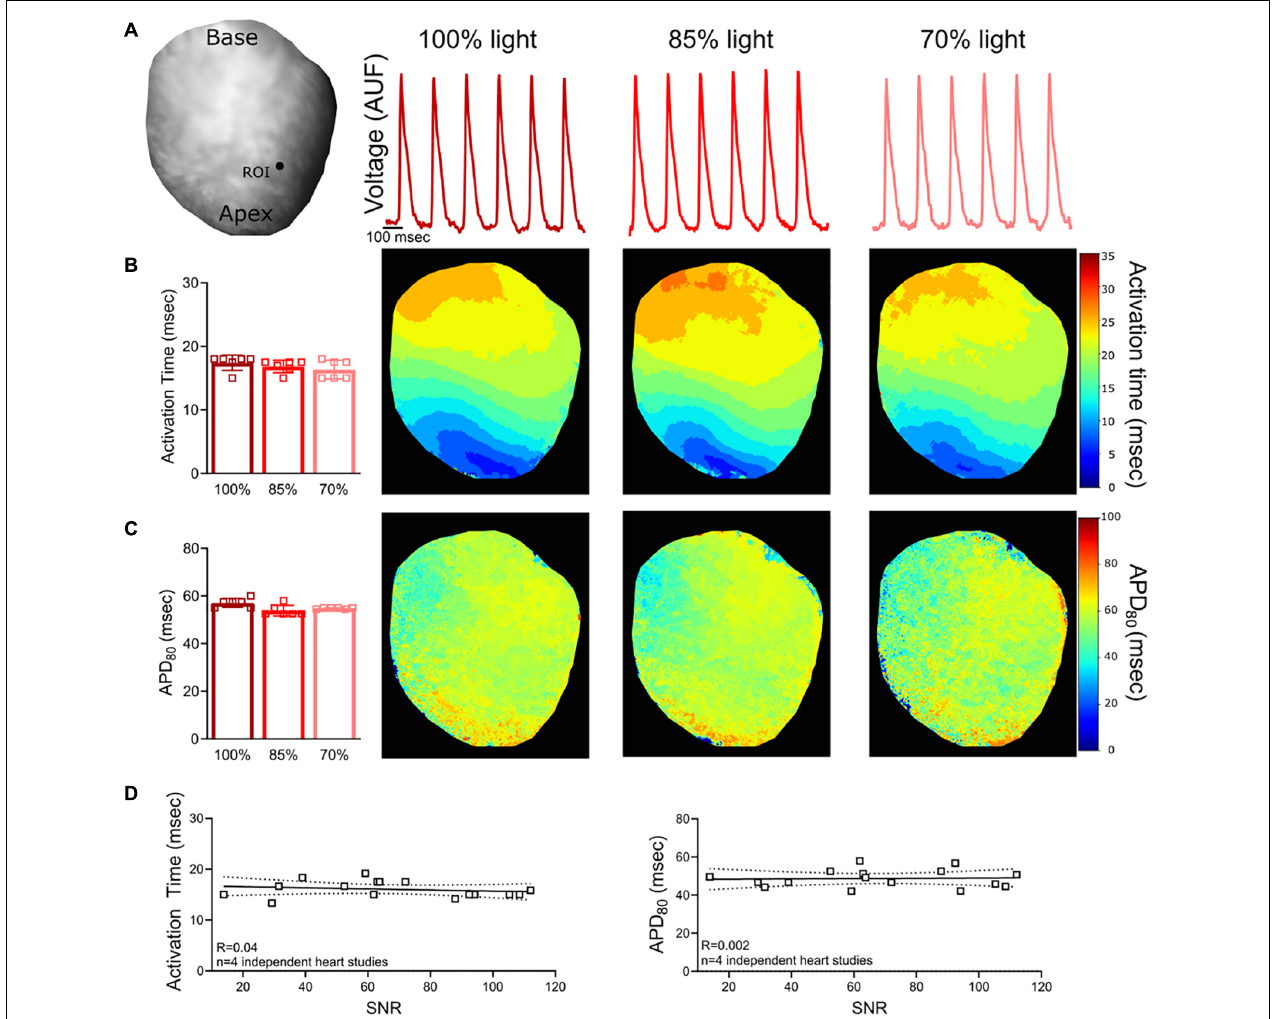
FIGURE 2 | Voltage Signal-to-Noise Ratio (SNR). (A) Representative rat heart loaded with voltage dye, RH237. Action potentials were analyzed from the same region of interest (ROI) on the epicardial surface ( n = 6 action potentials, same heart with diminished light illumination). (B) No measurable change in activation time was noted when the excitation light intensity and SNR was reduced ( n = 6 action potentials, same heart). (C) Calculated APD 80 values also remained consistent ( n = 6 action potentials, same heart). (D) Relationship between SNR and action potential measurements ( n = 4 optical signals collected from n = 4 independent